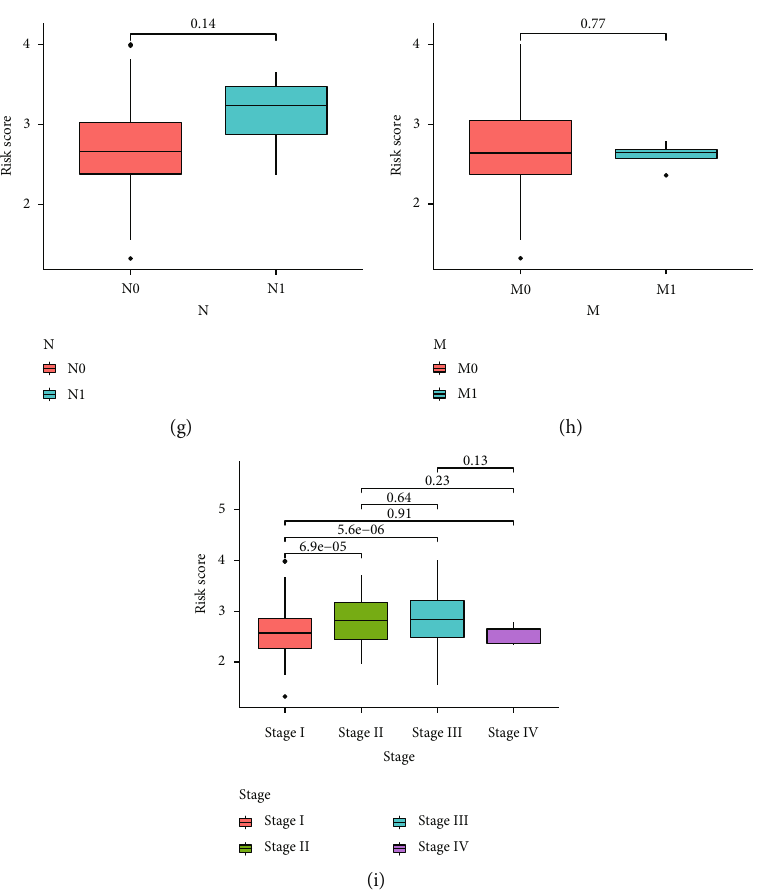
Figure 7: Exploration of the independent prognostic value and clinical feature of the risk score in HCC. (a, b) Through univariate and multivariate Cox regression analysis, the risk score was found to be an independent prognostic element for HCC patients. (c – i) The relationship between the risk score and di ff erent clinical parameters of